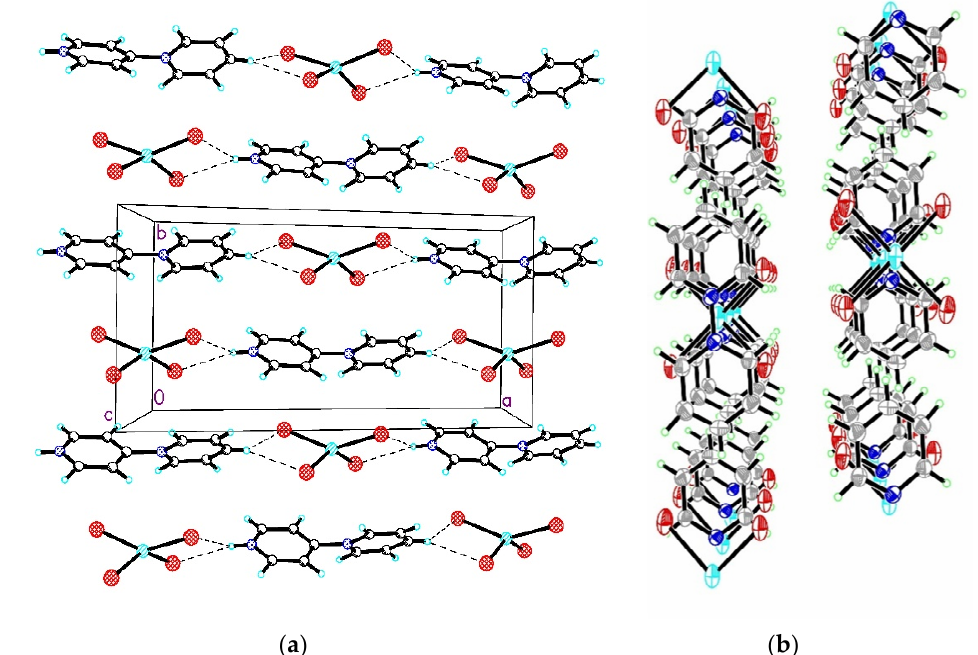
Figure 4. ( a ) Packing of B1H and CuBr 4 units into a layer in 2 , viewed parallel to the b -axis. ( b ) Packing of layers in 2 , viewed parallel to the c -axis.